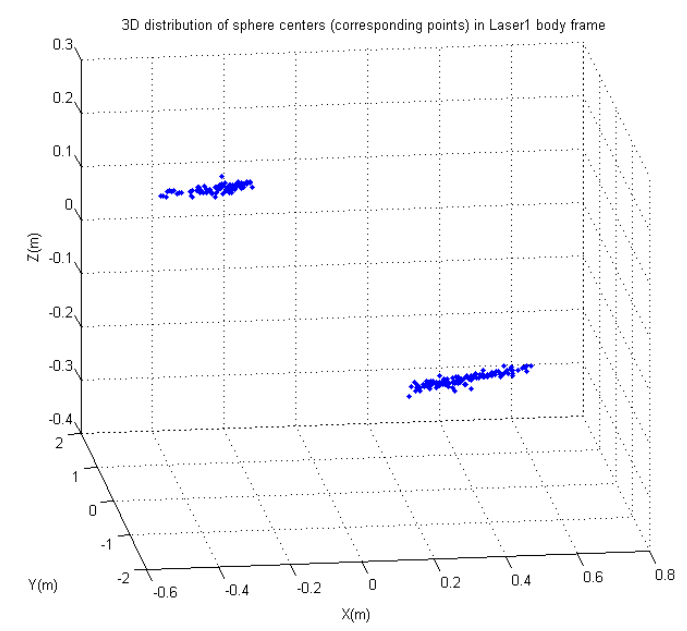
Figure 6. Circle fitting residuals on a laser scan. The maximum residual error is no more than 0.005 m. The root mean square (RMS) of the residuals is 2.5 mm.